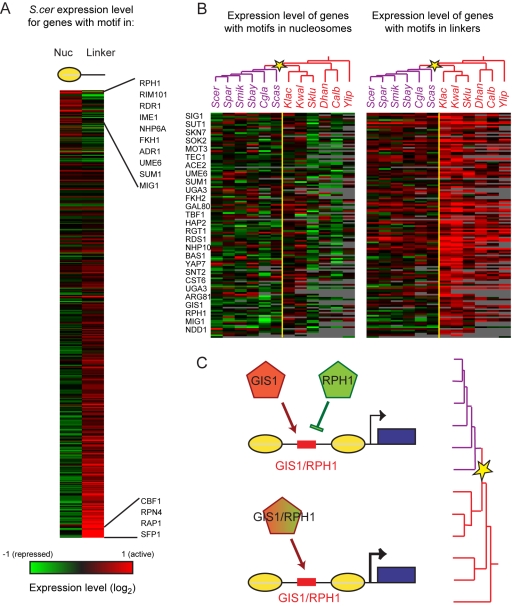
Evolution of transcription factor activity is reflected in divergence of activity of NFR-localized binding sites.(A) Nucleosome positions can be used to infer the positive or negative role of TFs in transcriptional control in S. cerevisiae. Average expression (mRNA abundance) of all genes with a given motif instance located in promoter nucleosomes (left) or NFRs (right). TFs are ordered by expression difference between NFR and nucleosomal binding sites, revealing transcriptional activators (bottom) and repressors (top) known to be active in these growth conditions. (B) Chromatin information reveals repressors associated with post-WGD nutrient control. For each species (columns) and each motif (rows), shown are mean expression levels of genes with the motif in nucleosomes (left matrix) or in linkers (right matrix). Shown are only the 138 motifs with increased activity in pre-WGD species [a correlation of over 0.5 to the vector (0,0,0,0,0,0,1,1,1,1,1,1)]. A small number of motifs were associated with higher activity in post-WGD species (unpublished data). Yellow star, WGD. (C) A model of increased regulatory capacity. Pre-WGD, only an single (activator-like) TF was present (GIS1/RPH1, bottom). Post-WGD (star), two paralogous TFs with the same sequence specificity are present in the genome (GIS1, RPH1, top), one is an activator (red), and the other a repressor (green).